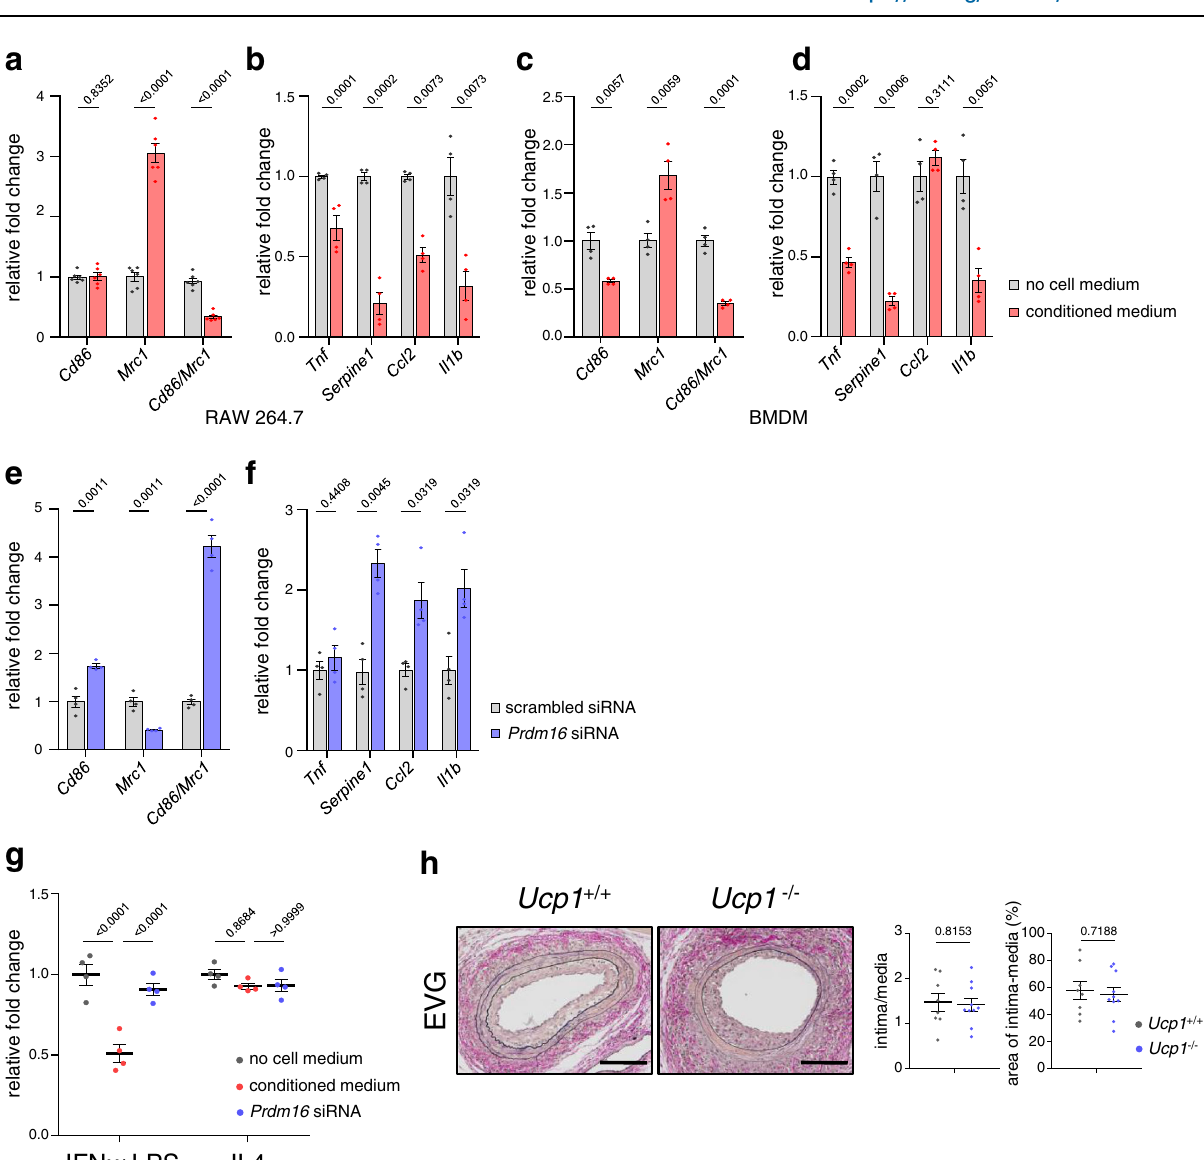
of the qRT-PCR analyses of the gene expression levels of macrophage phenotype markers ( e ) and in fl ammatory cytokines ( f ) are shown ( n =4, biological replicates, representativedataofthreedifferentculturelinesareshown,two-tailed t testswith Holm-Sidak ’ s correction for multiple comparisons). g Cell growth analysis of RAW 264.7 cells 72h after treatment with culture media conditioned by PVAT-derived beige adipocytes. RAW 264.7 cells were pre-treated with IFN γ (20ng/ml) and LPS (20ng/ml)orIL4(10ng/ml)for24handtreatedwithmediaculturedintheabsence of adipocytes (gray dots), culture media conditioned by adipocytes (red dots) and culture media conditioned by adipocytes introduced by Prdm16 siRNA (blue dots) ( n =4 biological replicates, representative data of three different culture lines are shown, one-way ANOVA followed by Tukey – Kramer post-hoc test). h EVG staining in the FA 14 days after injury in Ucp1 − / − and wild type ( Ucp1 +/+ ) mice. Scale bars represent 100 μ m. The ratio of intima to media area (intima/media) and % intima – medial area in the area surrounded by the external elastic lamina (area of intima – media) were analyzed ( Ucp1 +/+ , n =8; Ucp1 − / − , n =10, unpaired two-tailed Student ’ s t test).Data represent mean±SEM. Source data are provided as aSource Data fi